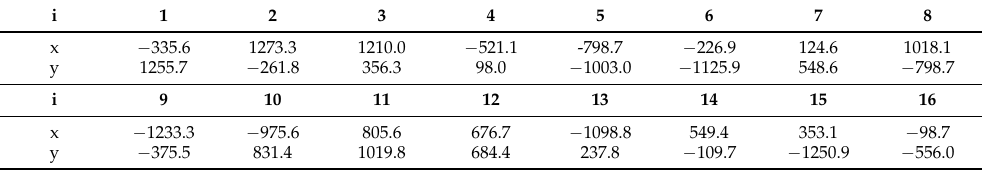
Table 5. Best turbine layout solution obtained by the DPCRO-SL (16 turbines, 1300 m